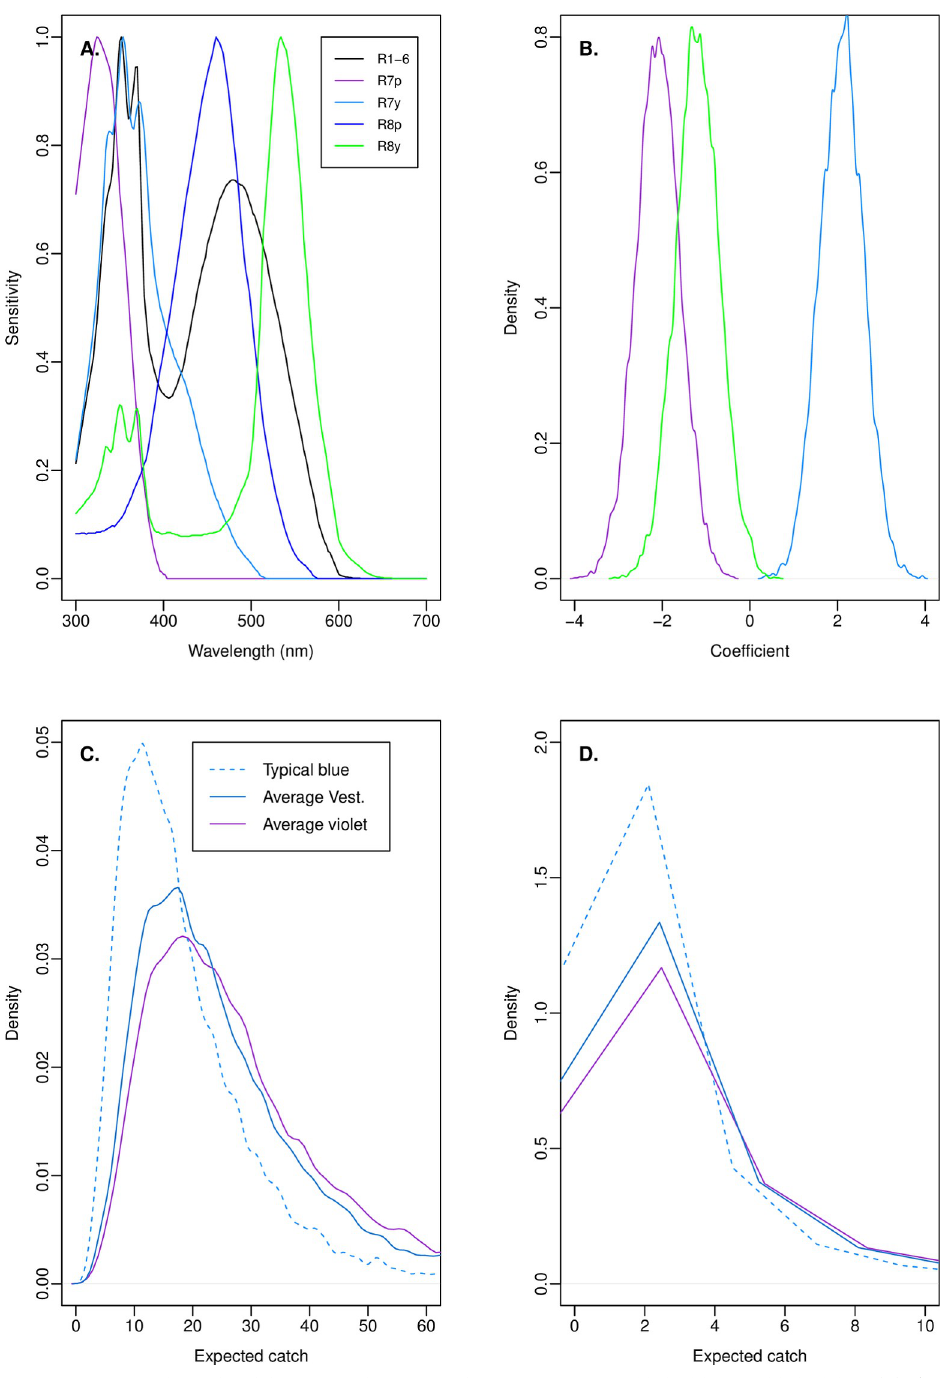
Fig 4. Bayesian analysis of G . f . fuscipes catches using informative priors established from published data. (A) Flies possess five classes of photoreceptor with characteristic spectral sensitivities [12], and the responses of these photoreceptors to target fabrics provide the only inputs to visually guided behaviour. The responses of these photoreceptors to each fabric can be calculated from the fabric’s reflectance spectrum and used as predictors of attraction in statistical models of tsetse catches [8,9]. (B) Prior probabilities for coefficients relating calculated photoreceptor responses to tsetse catches, based on analysis of data published in [4]. Only the three photoreceptors deemed most influential in earlier work have been considered [8,9]. Plot shows random samples with the means and standard deviations specified in methods. (C) Probability density functions for 10,000 expected catches computed for typical blue, ‘average Vestergaard’, and ‘average violet’ targets based upon the posterior probabilities of